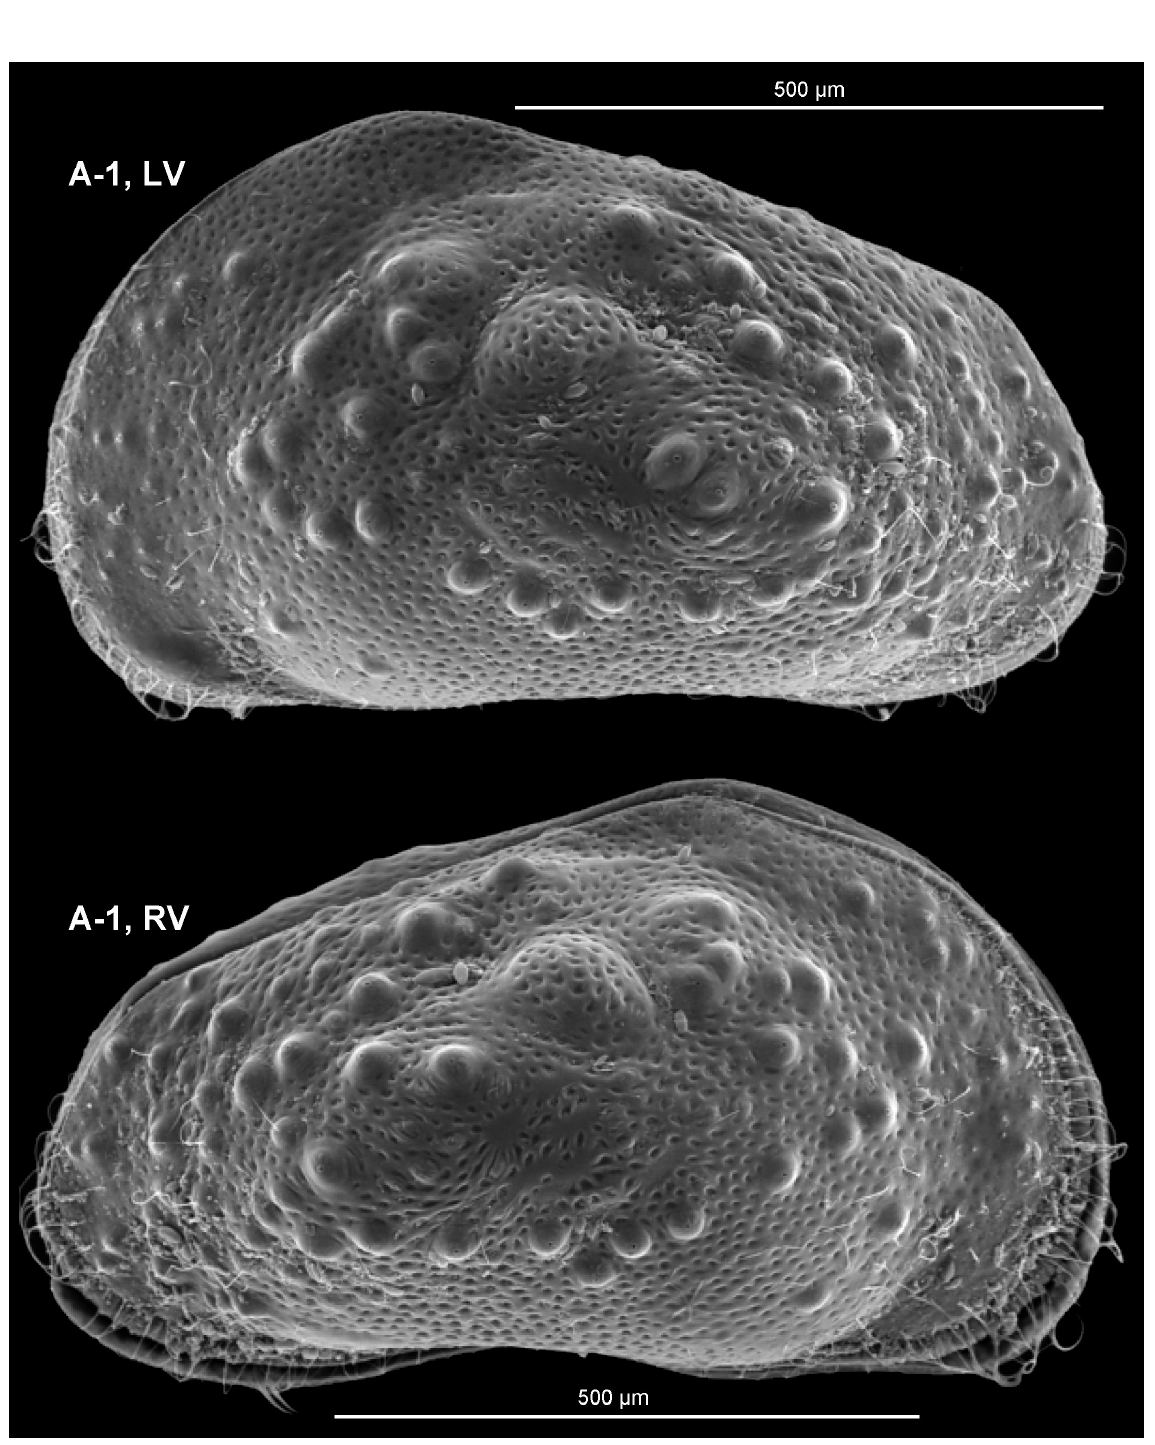
Fig. 4. Lateral external views of carapaces of A-1 juveniles of Bennelongia cf . nimala nov. sp. from Muggon Lake. Top in left lateral view and bottom in right lateral